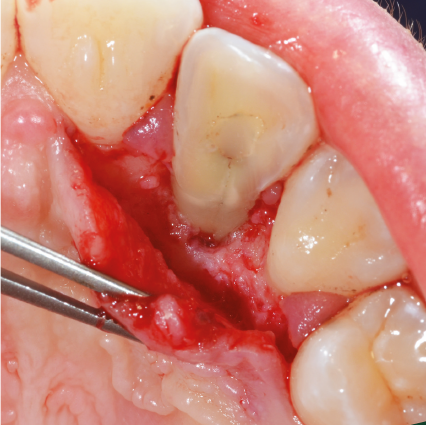
Figure 14: The radicular groove was smoothed using a diamond